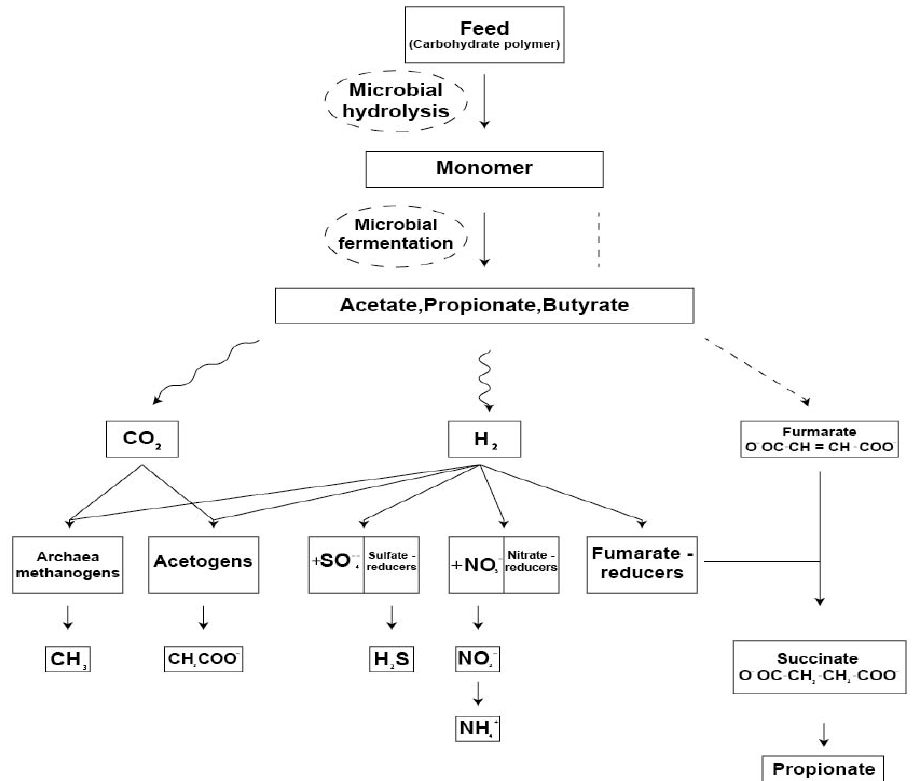
Figure 2. Biochemical pathways for CH 4 synthesis (adapted from [24]). This figure is excluded from the CC BY licence under which this article is